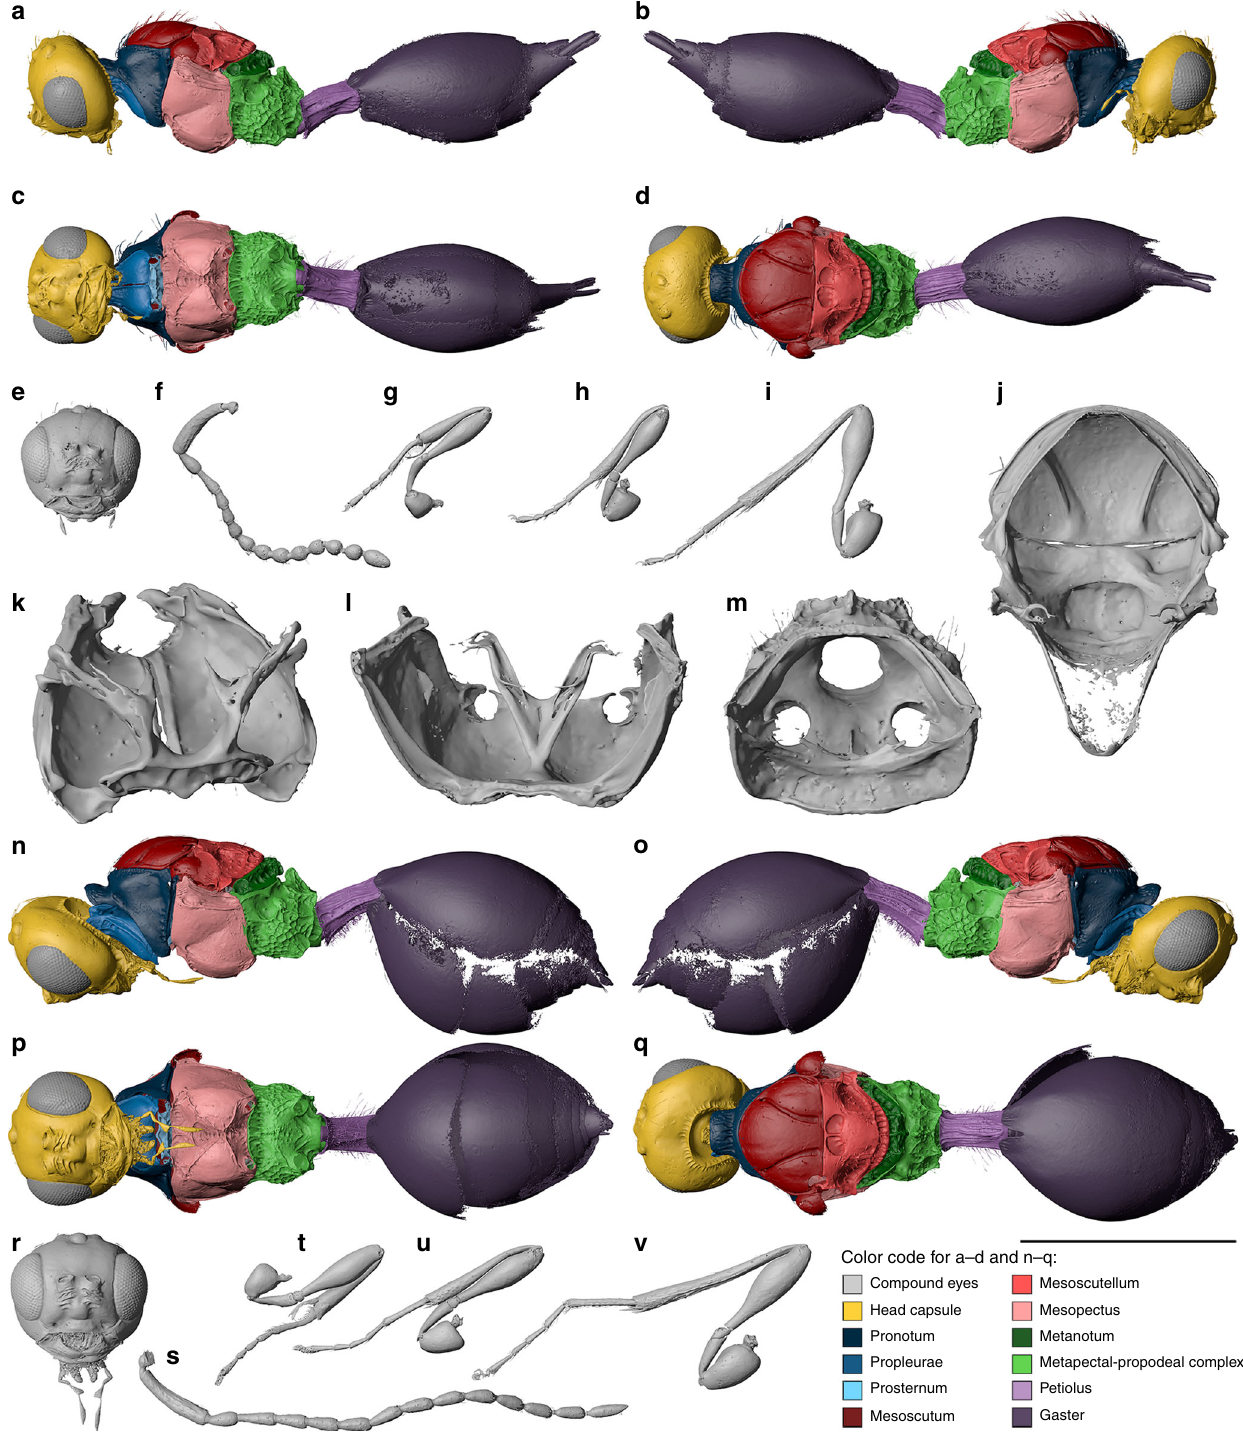
Fig. 4 Digital reconstruction of Xenomorphia resurrecta gen. & sp. nov. (Diapriidae: Diapriinae: Spilomicrini). Female holotype NMB F2875 ( a – m ) and male paratype NRM-PZ Ar65720 ( n – v ). Habitus ( a – d ), head ( e ), left antenna ( f ), left foreleg ( g ), right midleg ( h ), right hind leg ( i ). Internal anatomical structures ( j – m ): mesonotum ventral view ( j ), propectus dorsolateral view ( k ), mesopectus anterior view ( l ), metapectal-propodeal complex anterior view ( m ). Habitus ( n – q ), head ( r ), left antenna ( s ), right foreleg ( t ), right midleg ( u ), right hind leg ( v ). Scale bar: a – i , n – v = 1 mm; j = 500 µ m; k = 250 µ m; l , m